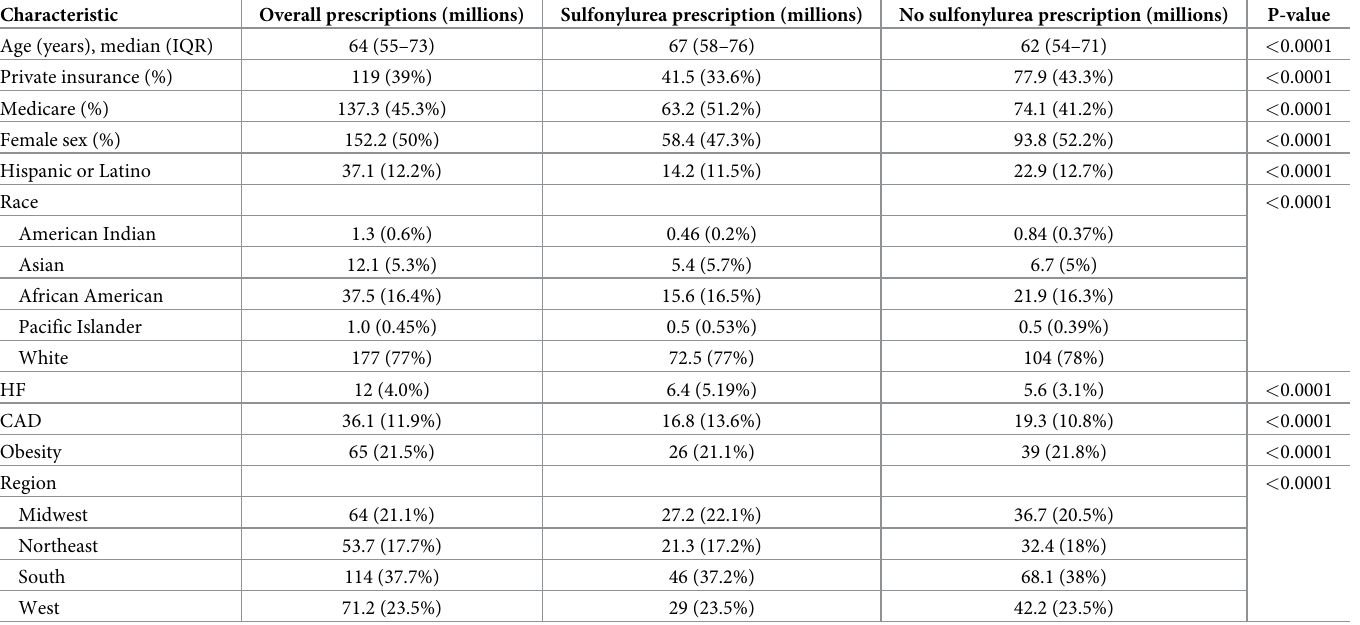
Table 1. Population